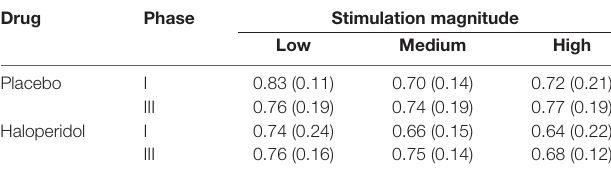
TABLE 3 | Proportion of hits in the absolute task for the first and third phase ( n = 20).